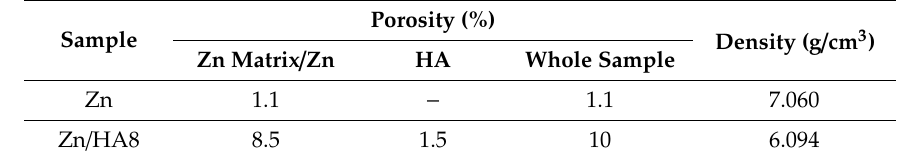
Table 2. Calculated porosity and density of prepared samples.